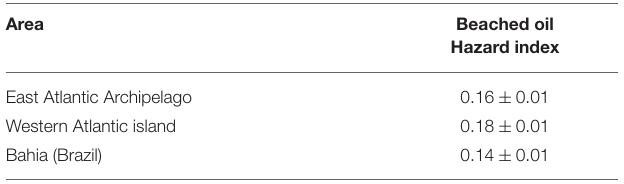
TABLE 4 | Beached oil hazard index calculated with Equation (3) for the three areas and the threshold value of 25